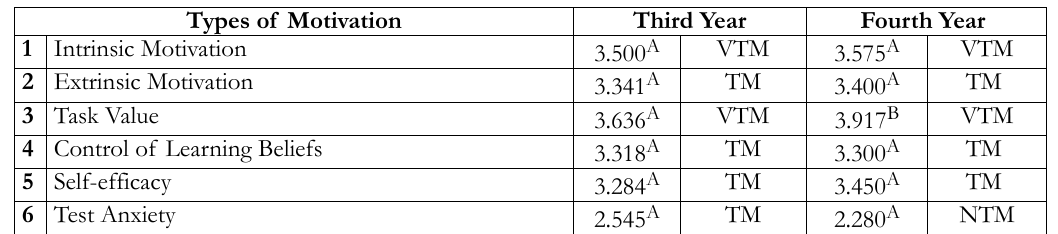
( 1 Means of the same letter within rows are comparable at .05 level of significance (t-test))